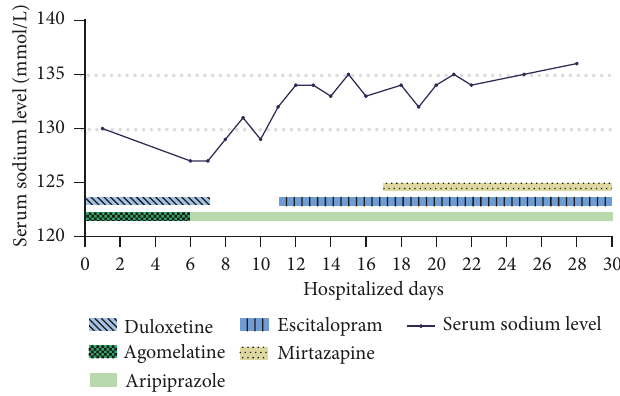
Figure 1: Patient’s serum sodium levels and antidepressant treatment regimen during hospitalization. Following discontinuation of agomelatineand duloxetine on the 6 th and 7 th day of hospitalization the patient’s serum sodium levelrose from 127 to 135 mmol/L. Ultimately, the patient’s depression was well managed with mirtazapine and aripiprazole with tapering of